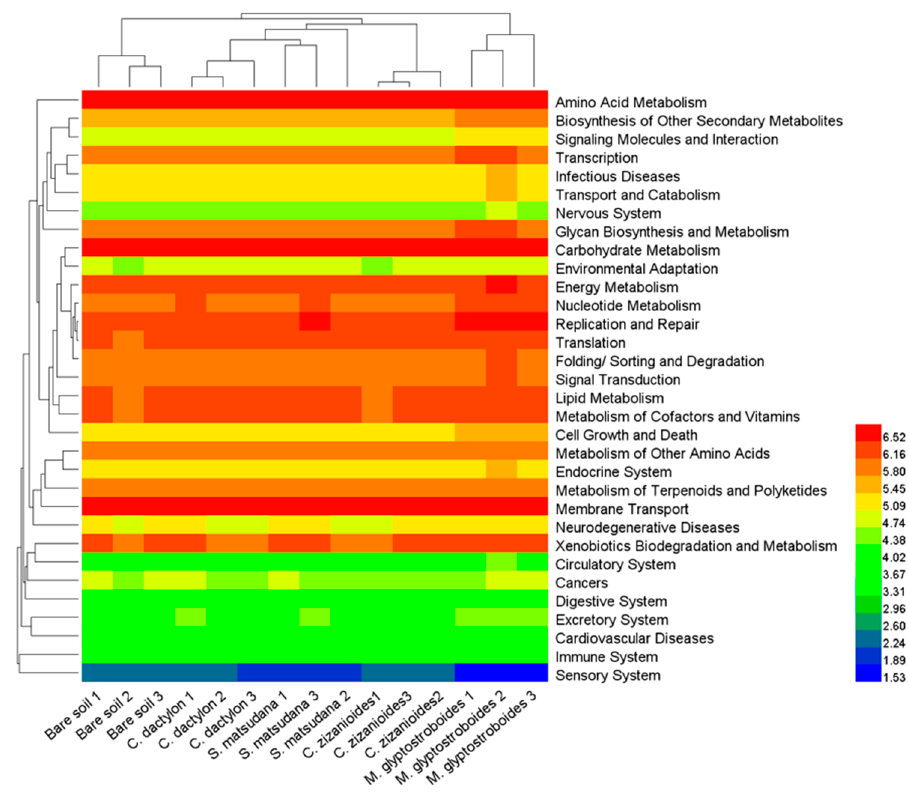
Figure 8. A heatmap showing the hierarchical clustering of the predicted Kyoto encyclopedia of genes and genomes (KEGG) Orthologs (KEGG level 2) gene copy number (log10 transformed) of bacterial microbiota across all samples. The digital number represents three biological replicates for each sample.